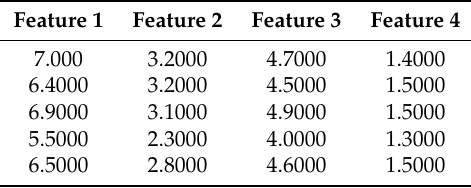
Table 6. Five samples from the first class (B).